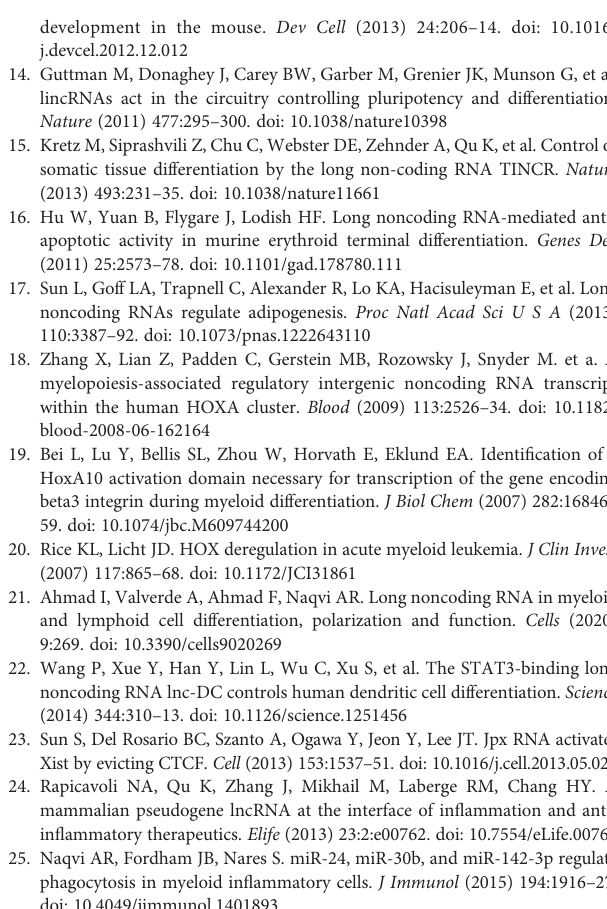
GAS5, IPW, ZFAS1, RN7SK or control and the cells were harvested after 72 h. The expression of lncRNAs was quanti fi ed by RT-qPCR and the fold change was calculated with respect to control siRNA. GAPDH was used as a housekeeping control. Each bar is representative of at least three different experiments and represents the mean ± standard deviation. Two-tailed t-test was used to evaluate statistical signi fi cance. **P < 0.01, ***P < 0.001 . SUPPLEMENTARY FIGURE 2 | Gating strategy and cell population used for M1 and M2 surface marker expression by fl ow cytometry. (A) Schematic view of the gating strategy used for fl ow cytometric analysis. Scatter dot plots showing the expression of (B) M1 and (C) M2 surface markers. SUPPLEMENTARY FIGURE 3 | Expression of M1 and M2 marker transcripts is not impacted by lncRNA knockdown. M1 or M2 macrophages were transfected with 100 nM siRNA targeting GAS5, RN7SK or control and total RNA was isolated after 72 h. Expression of (A) CD206, (B) CD163 and (C) CD23 was quanti fi ed by RT-qPCR and the fold change was calculated with respect to control siRNA. GAPDH was used as a housekeeping control. Each bar is representative of at least three different experiments and represents the mean ± standard deviation. Two- tailed t-test was used to evaluate statistical signi fi cance. SUPPLEMENTARY FIGURE 4 | Scatter dot plots showing cell population of M1 and M2 macrophages after phagocytosis assay. (A) Schematic view of the gating strategy used for phagocytosis assay analysis. Dot plots of population showing the phagocytosis of pHrodo Green labelled E. coli by (B) M1 and (C) M2